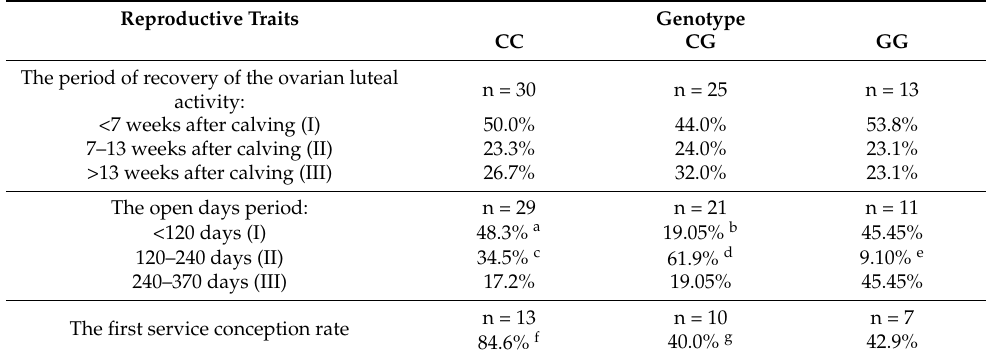
Table 2. The frequency of occurrence of cows with different reproductive traits in groups with polymorphic variants of the DIO1